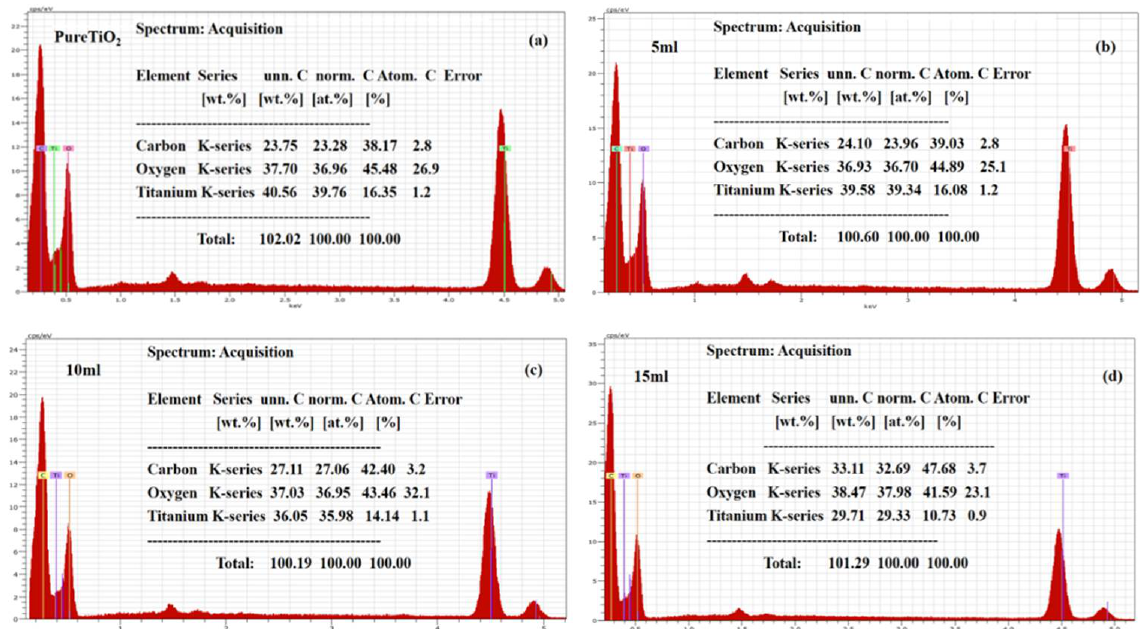
Figure 2. EDX analysis of bulk TiO 2 that has been hydrothermally treated ( a ) and treated with 5, 10, and 15 mL of FC leaf extracts ( b – d ) .